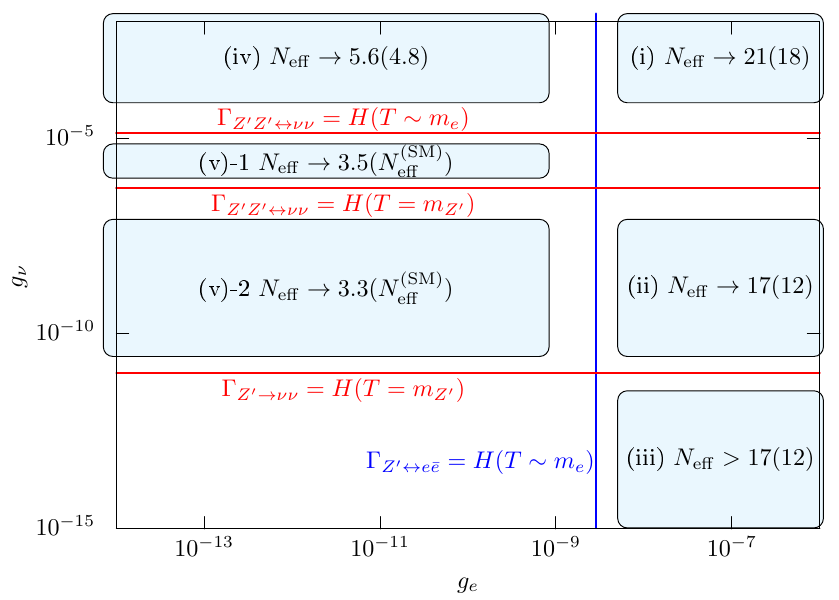
Figure 5. Schematic picture of summary of the each case study of the section